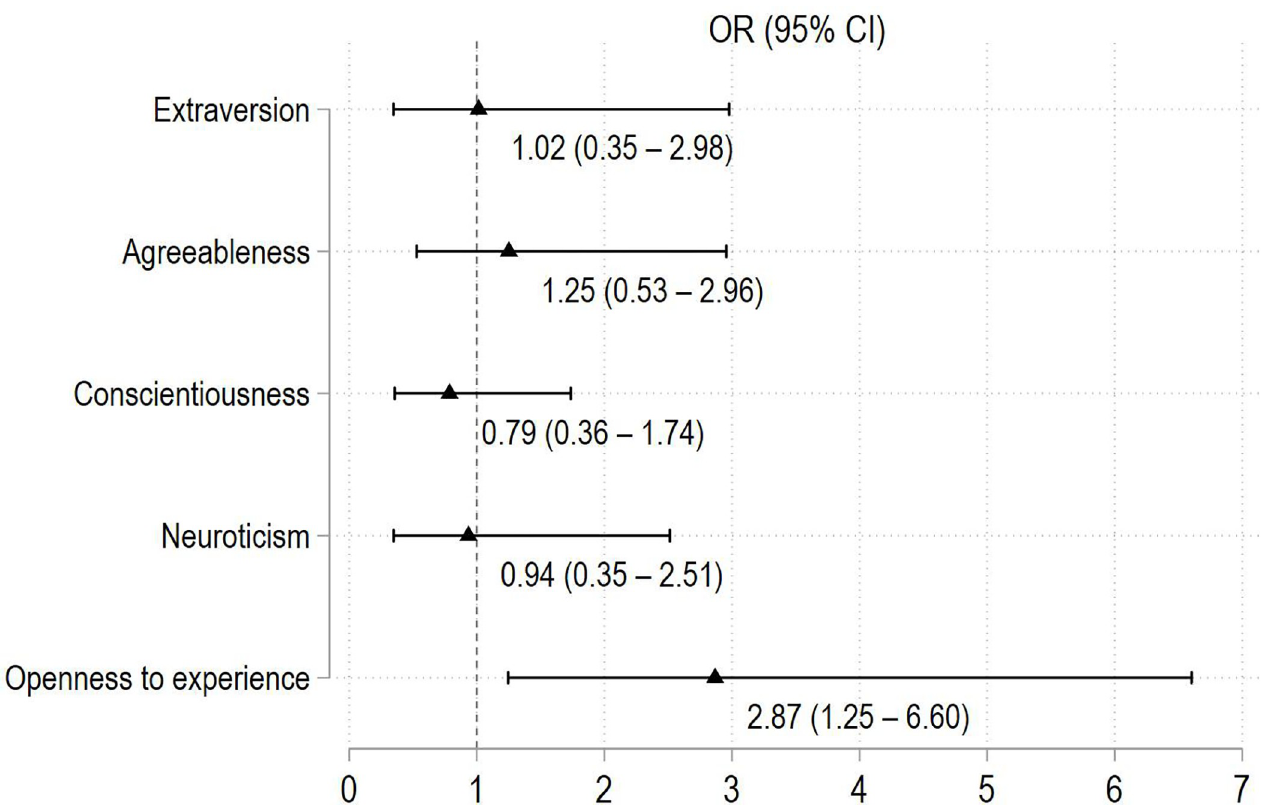
Fig 2. Forest plot with unadjusted odds ratios for personality scores in patients with medicinal cannabis use. Data are presented as unadjusted odds ratios with lower and upper 95% confidence intervals.